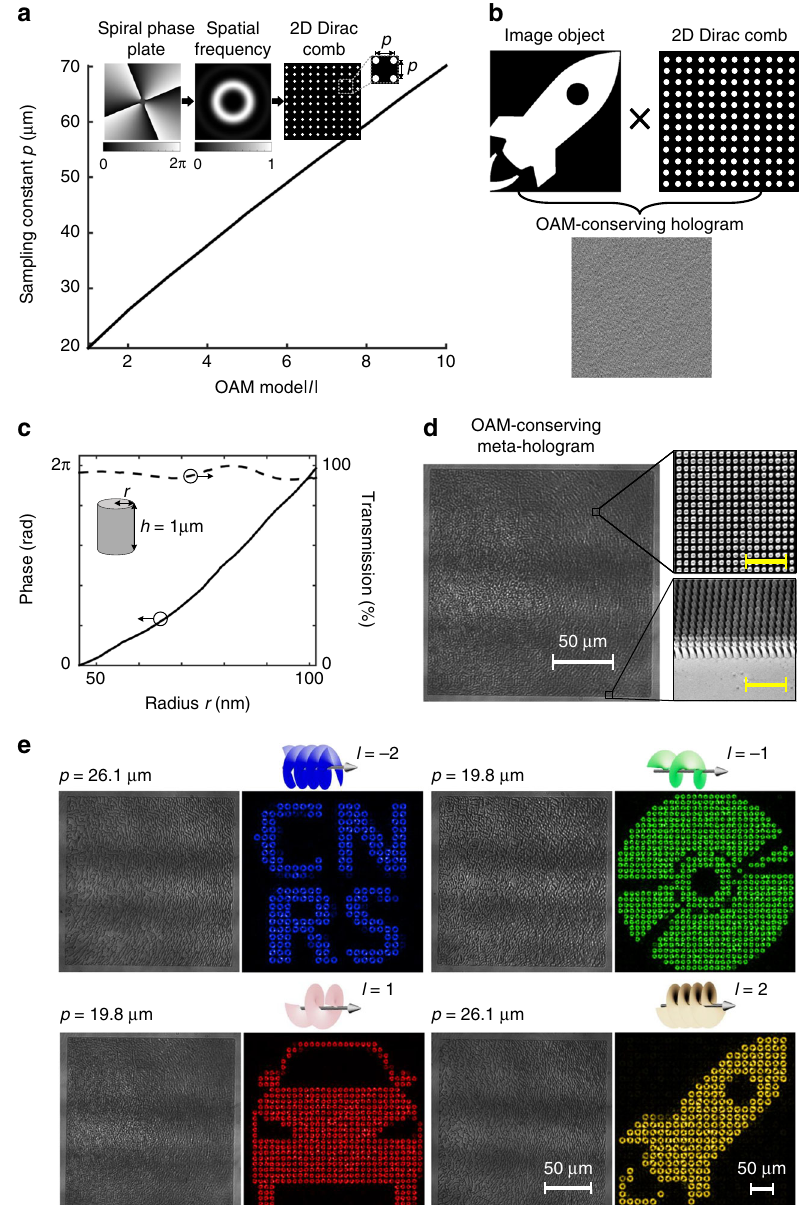
Fig. 2 Design and fabrication of an OAM-conserving meta-hologram. a Numerical characterization of OAM-dependent spatial frequency sampling of an OAM-conserving meta-hologram. Insets show that a spatial frequency analysis of a spiral phase plate that is used for the generation of an incident OAM beam leads to a doughnut-shaped intensity distribution in the image plane, which further determines the sampling constant ( p ) of an OAM-conserving meta-hologram. Avoiding interference between OAM pixels in the image plane is required to maintain the OAM information. This indicates that the image sampling size has to increase with the OAM topological charges. b Schematic design of an OAM-conserving meta-hologram through multiplying an object image with an OAM-dependent 2D Dirac comb function (a constant periodicity: p ) in the image plane. c Characterization of transmission ef fi ciency and phase response of GaN nanopillars as a function of nanopillars radius at a wavelength of 632 nm, respectively. d The optical image of a fabricated OAM- conserving meta-hologram, where the top- and oblique-view scanning electron microscopy images of enlarged areas in the meta-hologram are presented. The scale bar in the inset is 2 µ m. e Experimental characterization of the lensless reconstruction of OAM-carrying holographic images from different OAM- conserving meta-holograms through using incident OAM beams with topological charges of l = ± 1 and± 2, respectively. The original “ disc ” , “ car ” , and “ rocket ” images were obtained from Flaticon, Free Icons Library, and Interactivecoding websites,